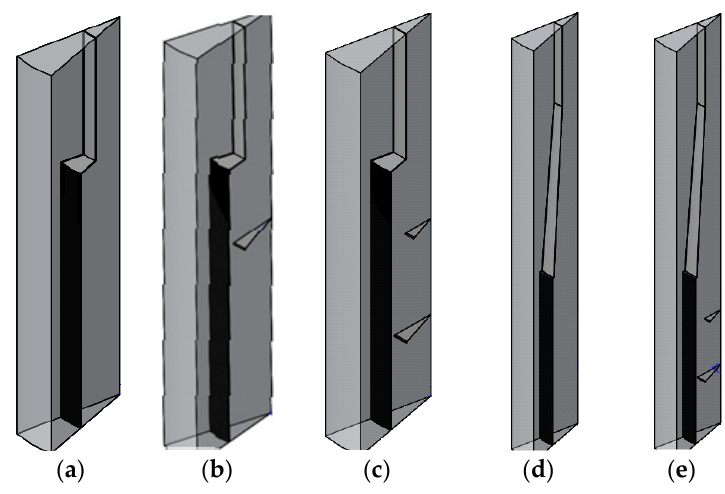
Figure 1. Design models of air distribution systems (1/16 sectors).